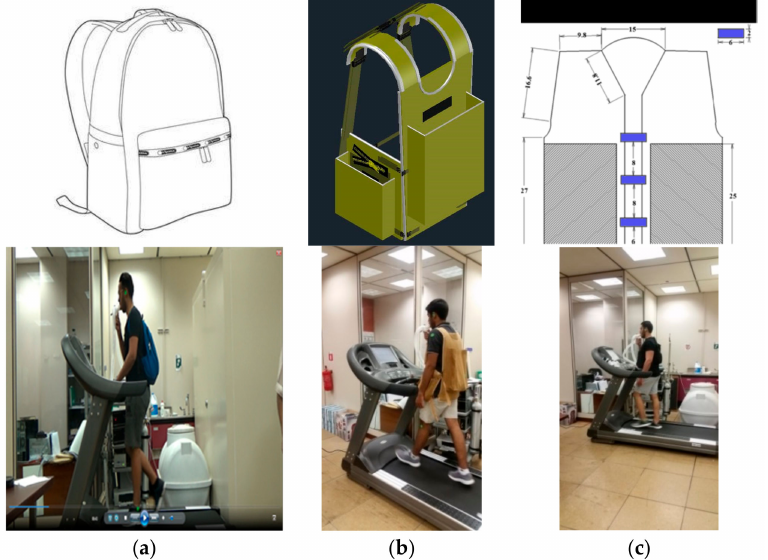
Figure 1. Backpacks used in the experiment. ( a ) popular school backpack; ( b ) and ( c ) backpack fabricated for the